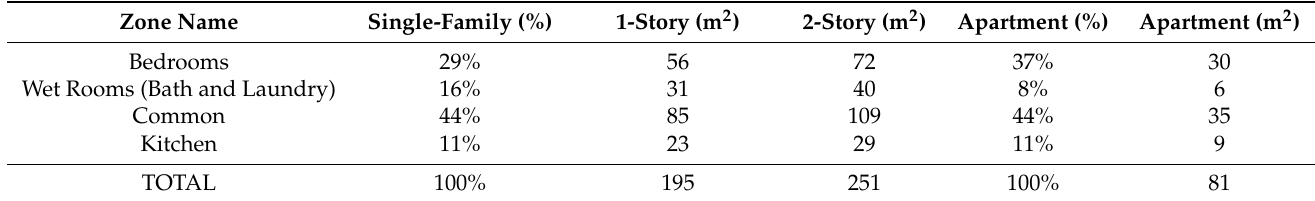
Table 1. Zone floor area and floor area fraction for each